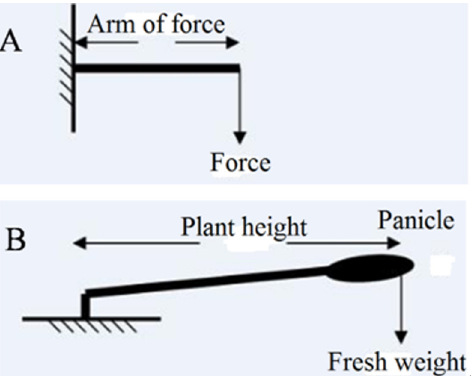
Fig 1. The schematic of bending moment (BM) was calculated using the following formula, BM = SL (stem length)×FW (fresh weight). Then, lodging index (bending moment/breaking resistance×100) was calculated for N 3 internode according to Amano et al. (1993) [23]. The diameter of N 3 near the lower node was measured after removing the leaf sheath. The dry weight of N 3 with leaf sheath was measured after oven drying at 80°C to constant weight. Dry weight of N 3 with leaf sheath per unit internode length (g cm − 1 ) was also calculated [14,